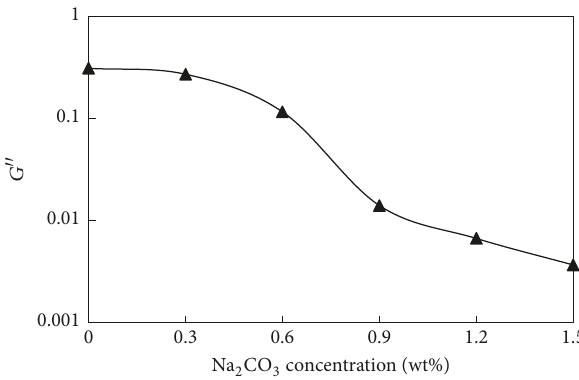
Figure 5: Relationship of G 󸀠󸀠 and Na 2 CO 3 concentration. The surfactant concentration is 0.3 wt% and polymer concentration is 2000